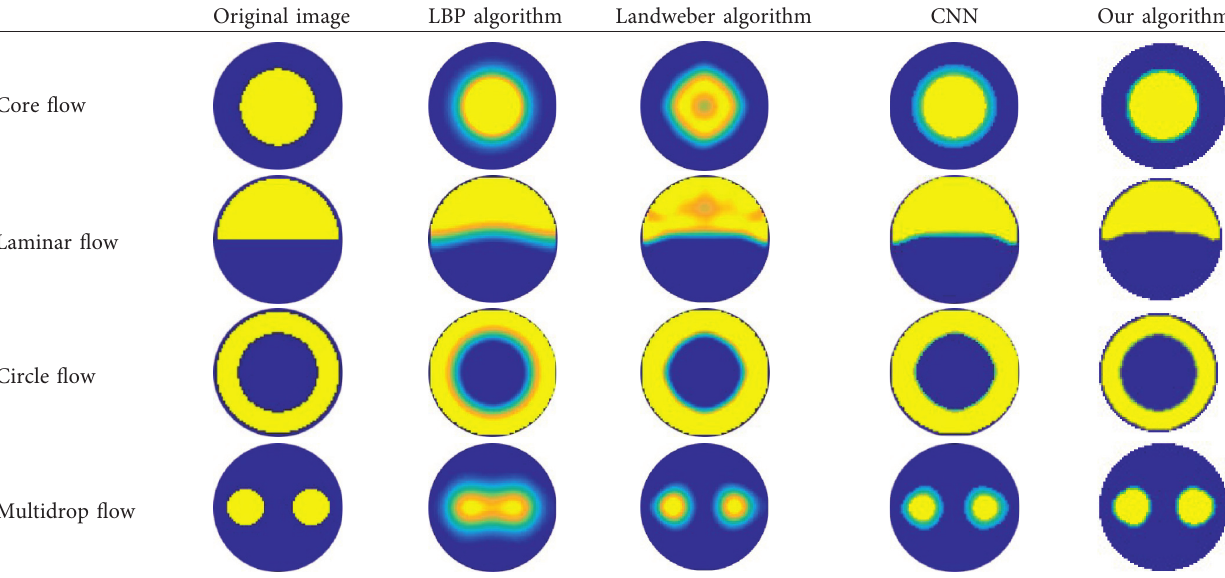
Table 7: Reconstruction comparison without noise.